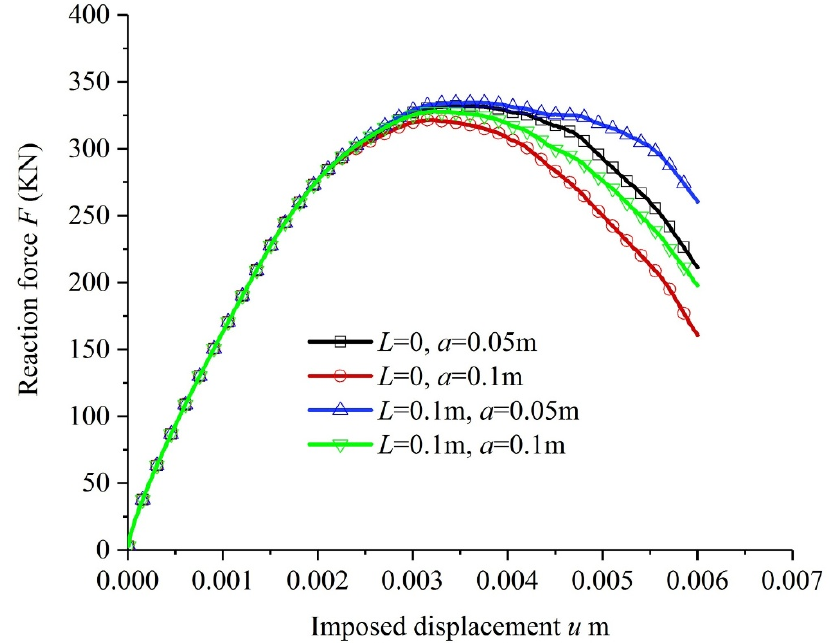
Figure 6. Curves of the reaction force versus imposed displacement for different kinds of pre-existing micro-cracks.